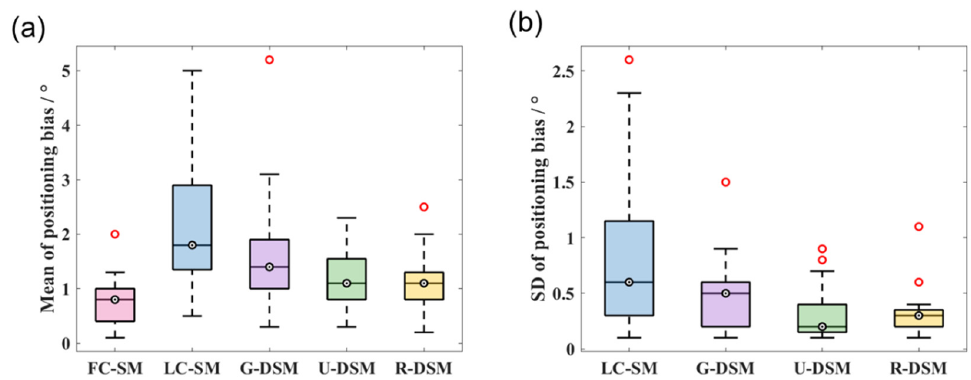
Figure 21. Box plots of ( a ) mean values and ( b ) SD values of positioning bias at 36 different source positions for 137 Cs source in inter-device evaluation.